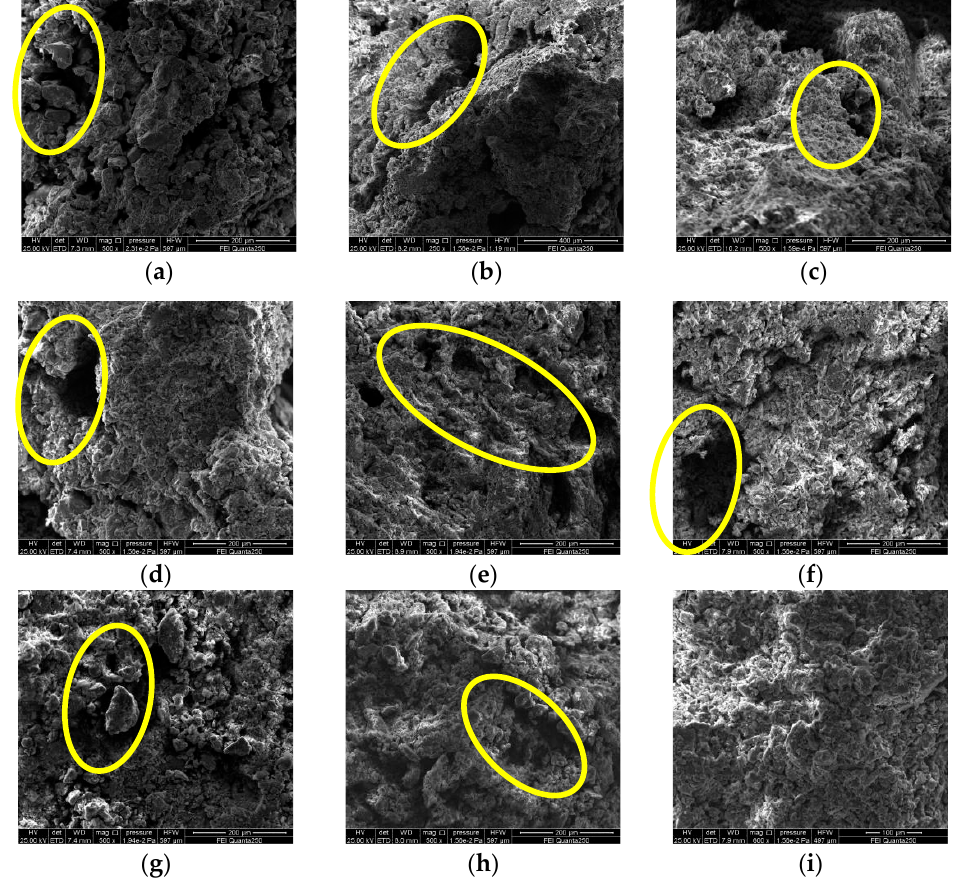
Figure 8. SEM image of dry shrinkage test. ( a ) A 1 B 1; ( b ) A 1 B 2; ( c ) A 1 B 3; ( d ) A 2 B 1; ( e ) A 2 B 2; ( f ) A 2 B 3; ( g ) A 3 B 1; ( h ) A 3 B 2; ( i ) A 3 B 3.